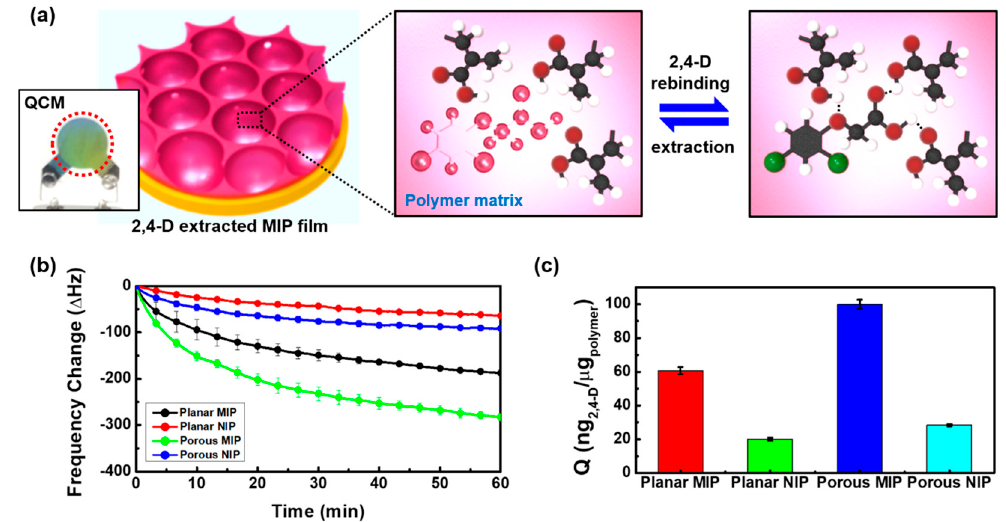
Figure 3. ( a ) Scheme of the rebinding and extraction process on the 2,4-D-extracted MIP film, ( b ) frequency change as a function of time on the p -MIP/NIP and pl -MIP/NIP films in 10 − 1 mM 2,4-D aqueous solution for the 1 h rebinding process (n = 3), ( c ) Q values (adsorbed 2,4-D mass (ng) per poly(MAA-co-EGDMA) unit weight (µg)) for the four samples.